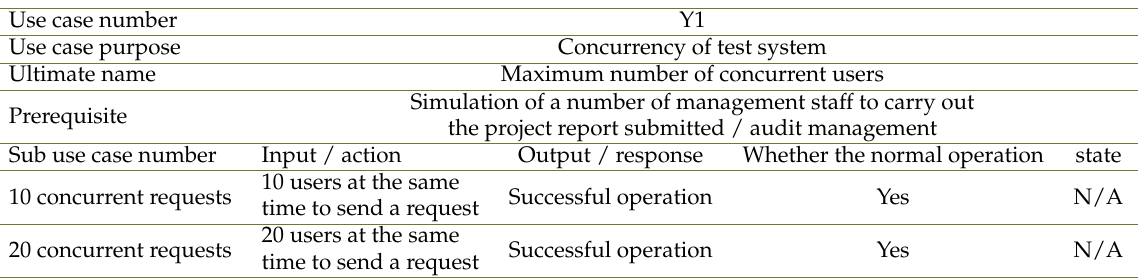
Table 2. Stress test